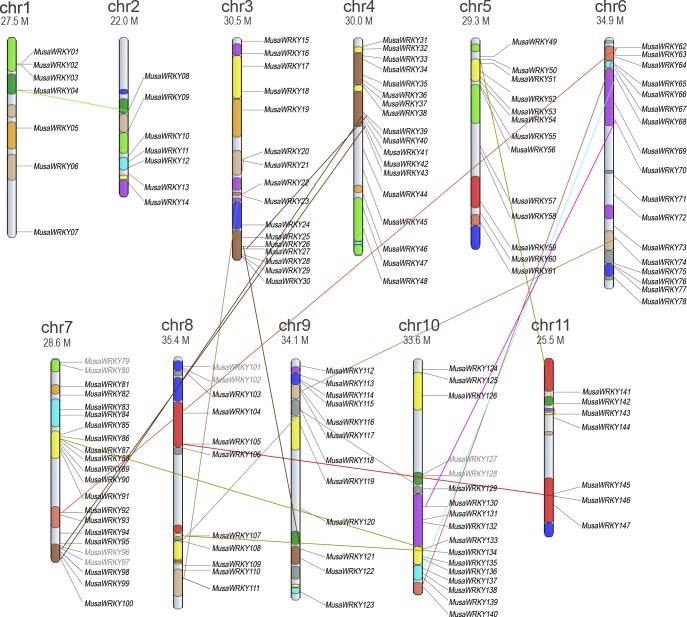
Chromosomal distribution of WRKY genes in Musa.Eleven synteny blocks of Musa chromosomes are represented as in the banana genome hub.The paralogous chromosome segments are represented in the same colors. The 17 paralogs are linked by the same colored lines. Number and size of the each chromosome are given at the top.